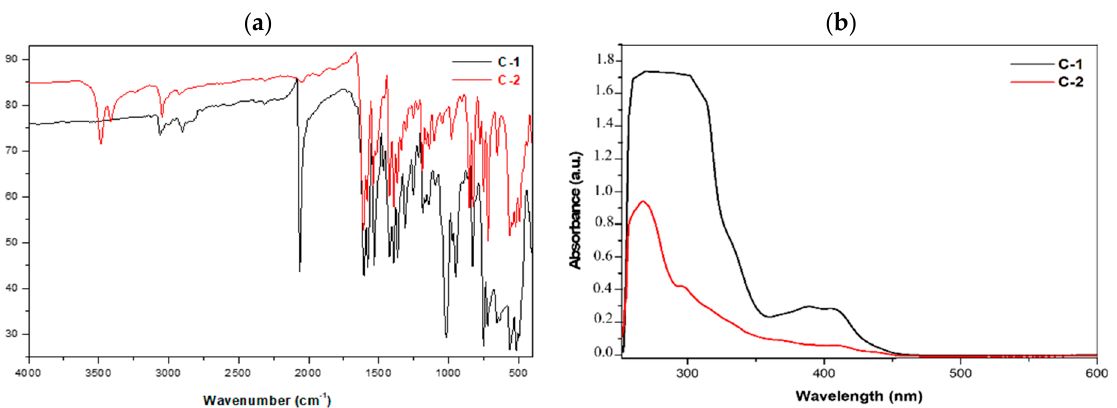
Figure 5. The FT–IR Spectrum ( a ) and the overlapping UV-visible spectrum in the DMSO ( b ) of complexes C-1 and C-2.